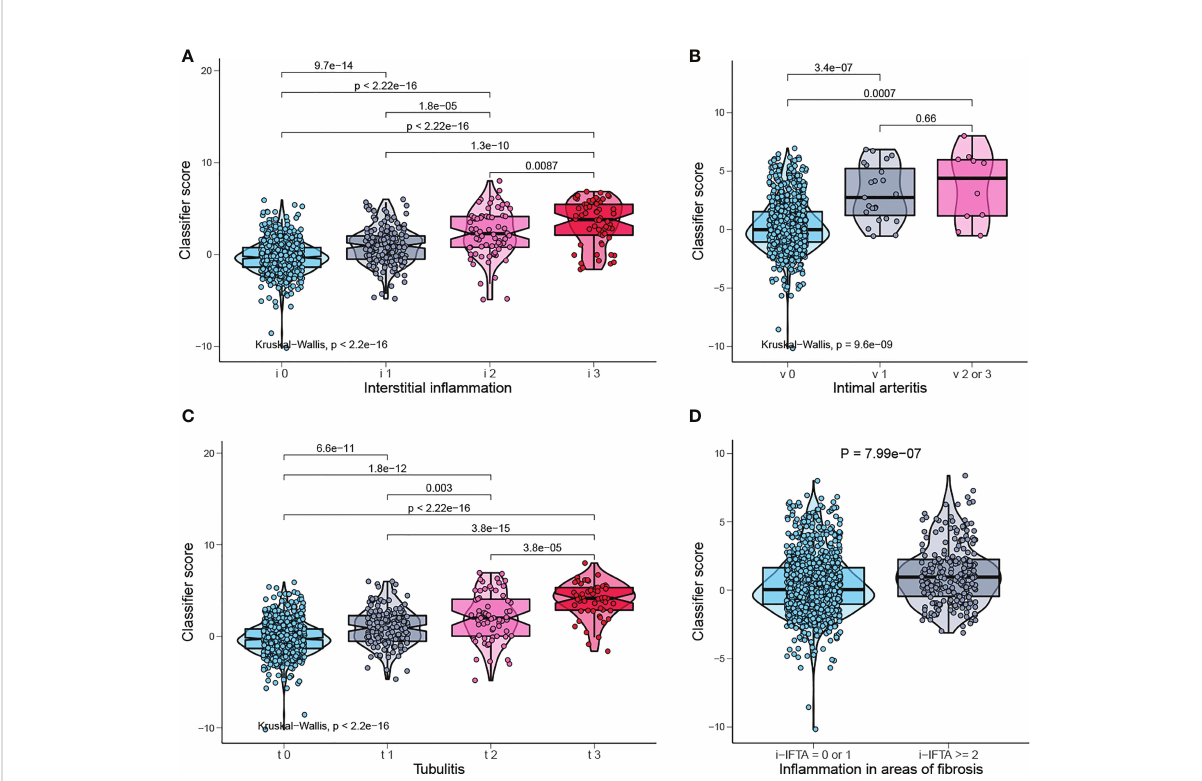
FIGURE 7 Classi fi er score in TCMR-related pathological lesion. (A) Classi fi er score in i0, i1, i2, i3, (B) v0, v1, v2 or 3, (C) t0, t1, t2, t3, and (D) i-IFTA=0 or 1, i-IFTA > =2. i, interstitial in fl ammation; t, tubulitis; v, intimal arteritis; i-IFTA, in fl ammation in areas of fi